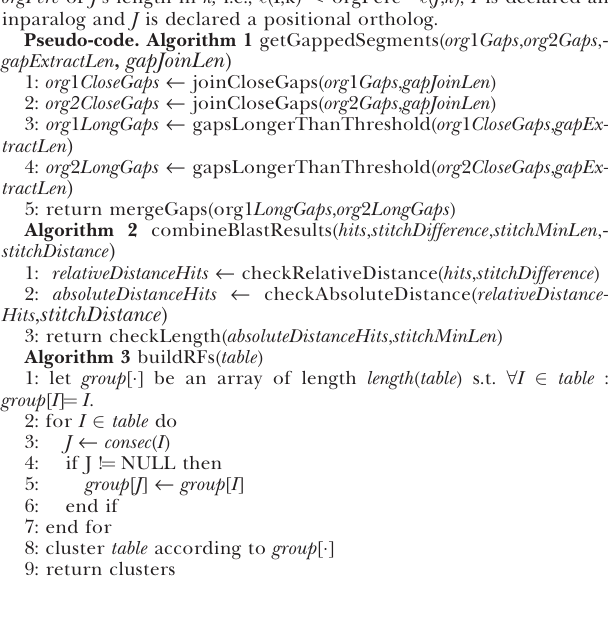
Figure S2. An Example of a False KO Anchor Resulting from a Nuisance Cross-Overlap in the Comparison of S. typhi ct18 and S. typhi ty2 Entry 2 (green) corresponds to K00357. By comparing it with Entry 1 and Entry 3, it is easy to see that Entry 2 corresponds to a false anchor and is a nuisance cross-overlap. Table S1. Running Mauve with Default Parameters on 10 Prokaryotic Pairs Table S2. Running Mauve with Nondefault Parameters on 10 Prokaryotic Pairs Table S3. Comparing Coverage between MAGIC’s and Mauve’s Results Table S4. Running MAGIC while Taking Mauve’s Backbone Results as Anchors Table S5. The One-to-One RF Table Resulting from Running MAGIC Mapping Phase and Filtering Entries of Length Smaller than 1,000,000 on the Human–Mouse X Chromosome Based on BLASTZ Chained Output as Available on the UCSC Genome